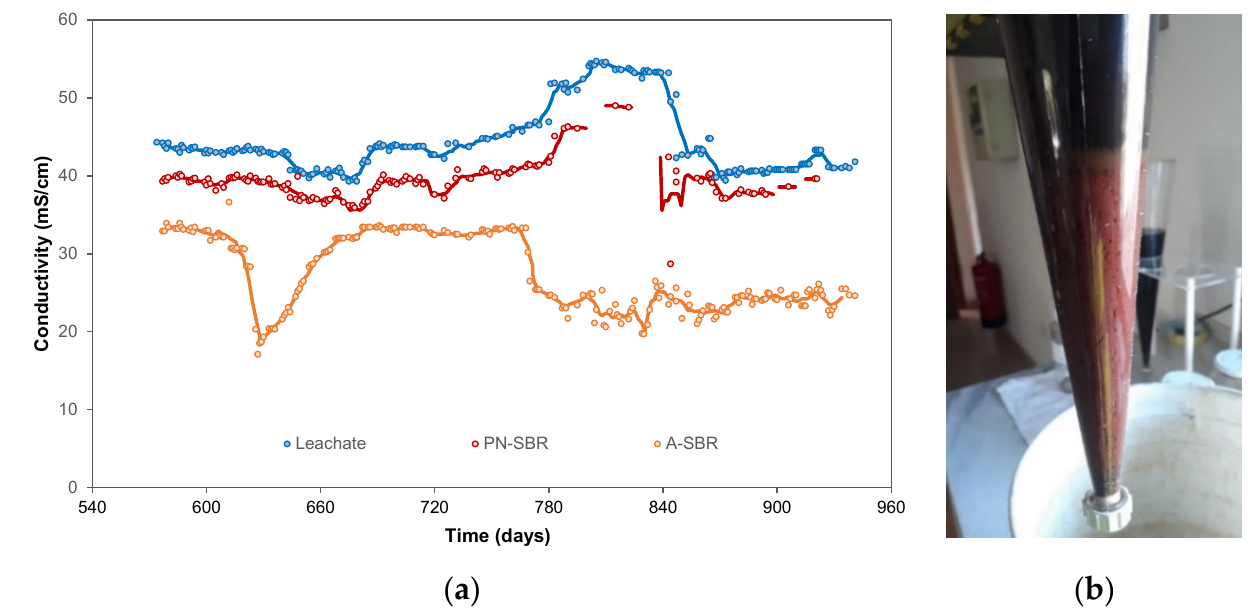
Figure 7. ( a ) Evolution of the conductivity in the treatment plant once the landfill site stopped receiving solid waste (day 486); ( b ) Detailed view of the biomass growing in A-SBR after decanta- tion in an Imhoff cone (January 2020).